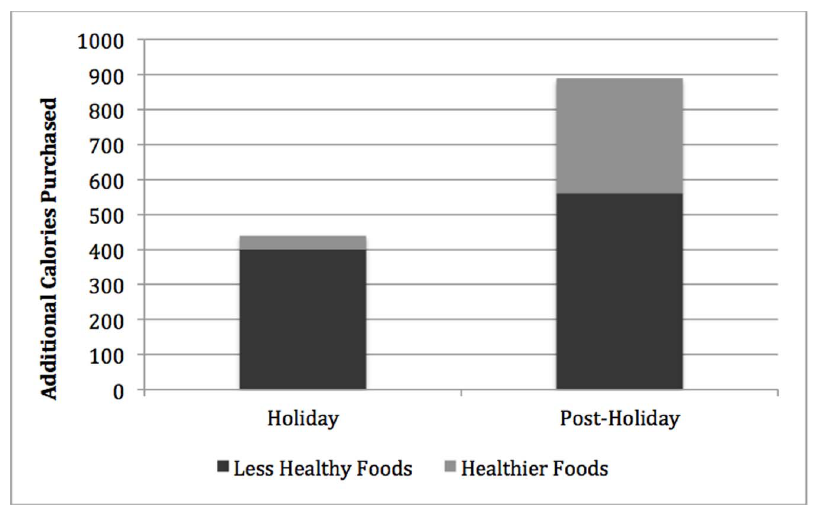
Figure 4. Households Purchased Additional Calories of Healthier Foods During the Post-Holiday Period. Additional calories were calculated by subtracting calories in the holiday and post-holiday seasons from baseline expenditures. Additional calories for the less healthy and healthier items were stacked to show total additional calories in the respective period.